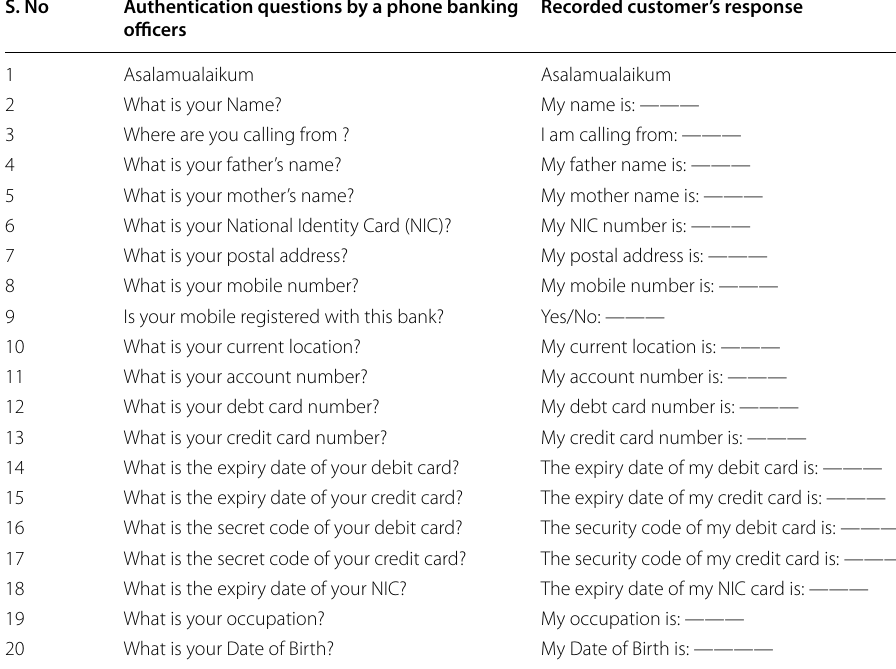
Table 2 Designed written script for English S.